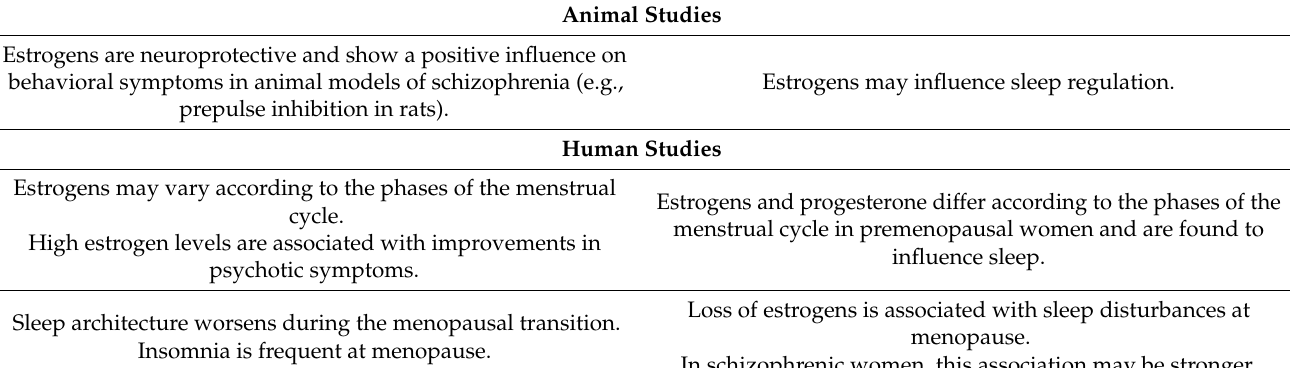
Table 2. Estradiol as a potential target to treat insomnia in postmenopausal women with